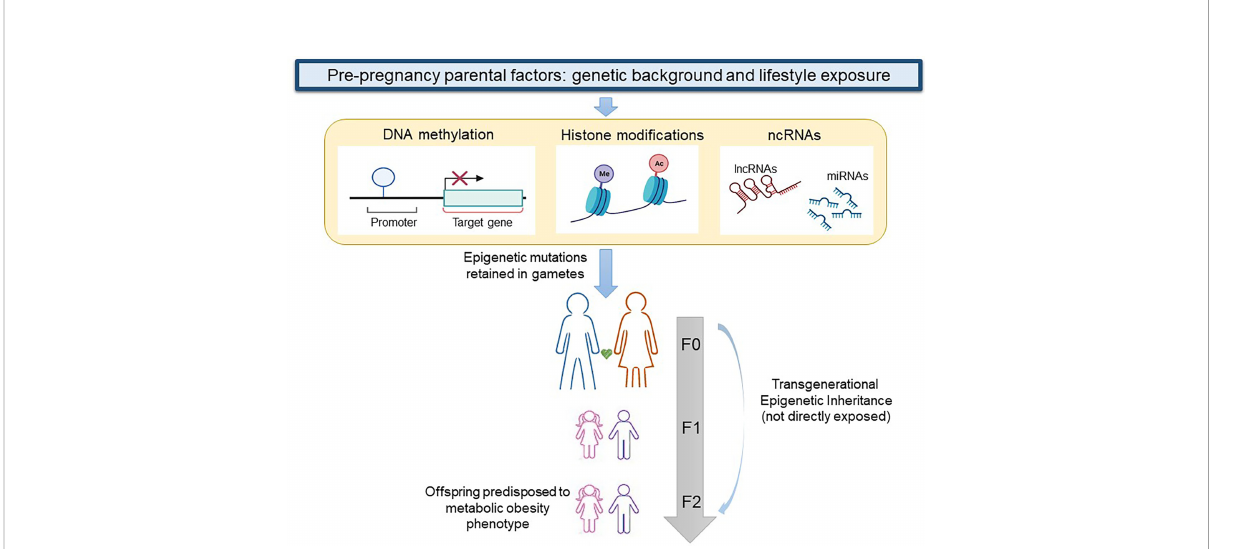
FIGURE 1 Transgenerational epigenetic inheritance of obesity. When genetic background and lifestyle exposure cause epigenetic modi fi cations (DNA methylation, histone modi fi cations, and changes in non-coding RNAs) in gametes of a woman or a man at F0, the fi rst generation that exhibits a transgenerational epigenetic inheritance is the F2. lncRNA, long non coding RNA; ncRNA, non coding RNA; miRNA, micro RNA. Figure partially created with